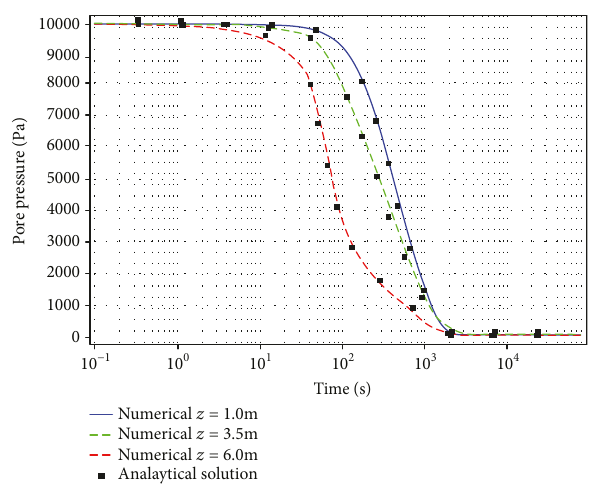
Figure 6: Pore pressure evolution with time at di ff erent positions within the soil column.